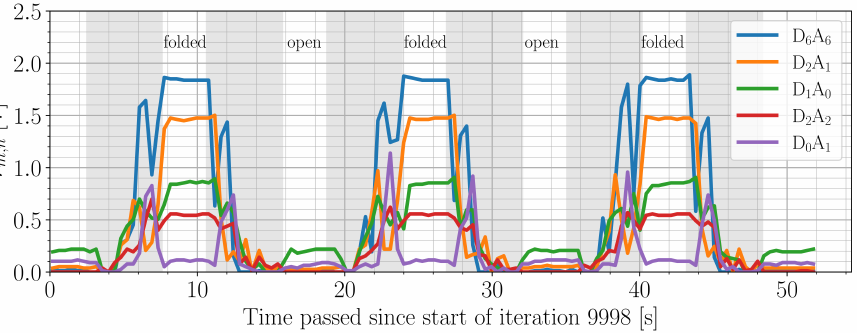
Figure 6. Raw textile output over iterations 9998–10,000 for the five highlighted matrix points in Figure